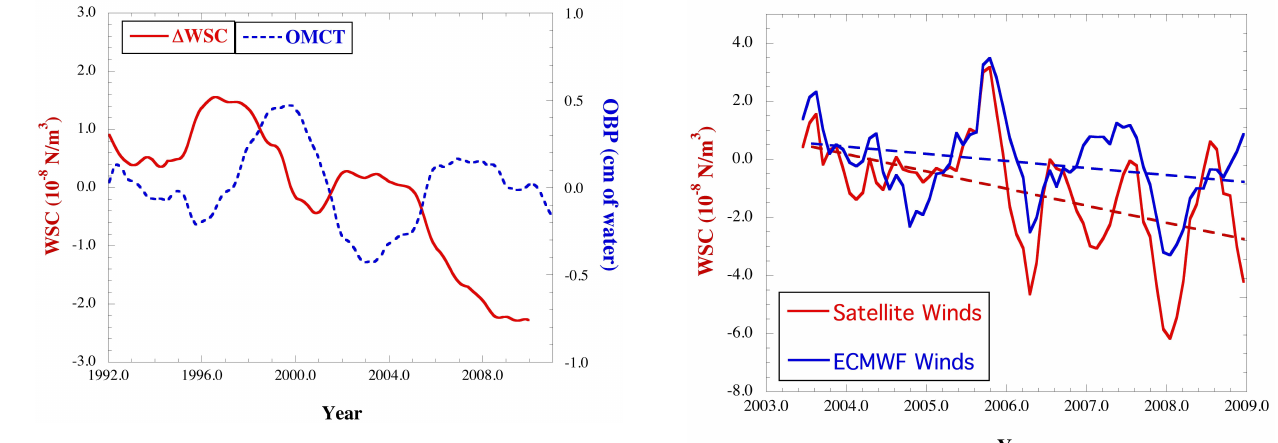
Fig. 10. 1 WSC (solid line, left axis) and OBP (dashed line, right axis) after low-pass filtering with a 2-year Gaussian to reduce ENSO and other interannual variability.